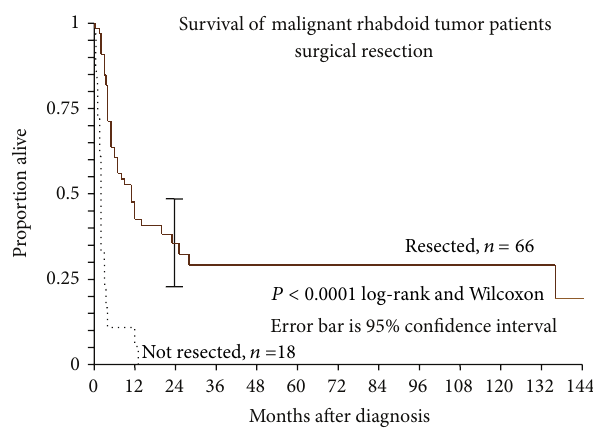
Figure 4: Kaplan-Meier survival of malignant rhabdoid tumor patients with and without surgical resection.